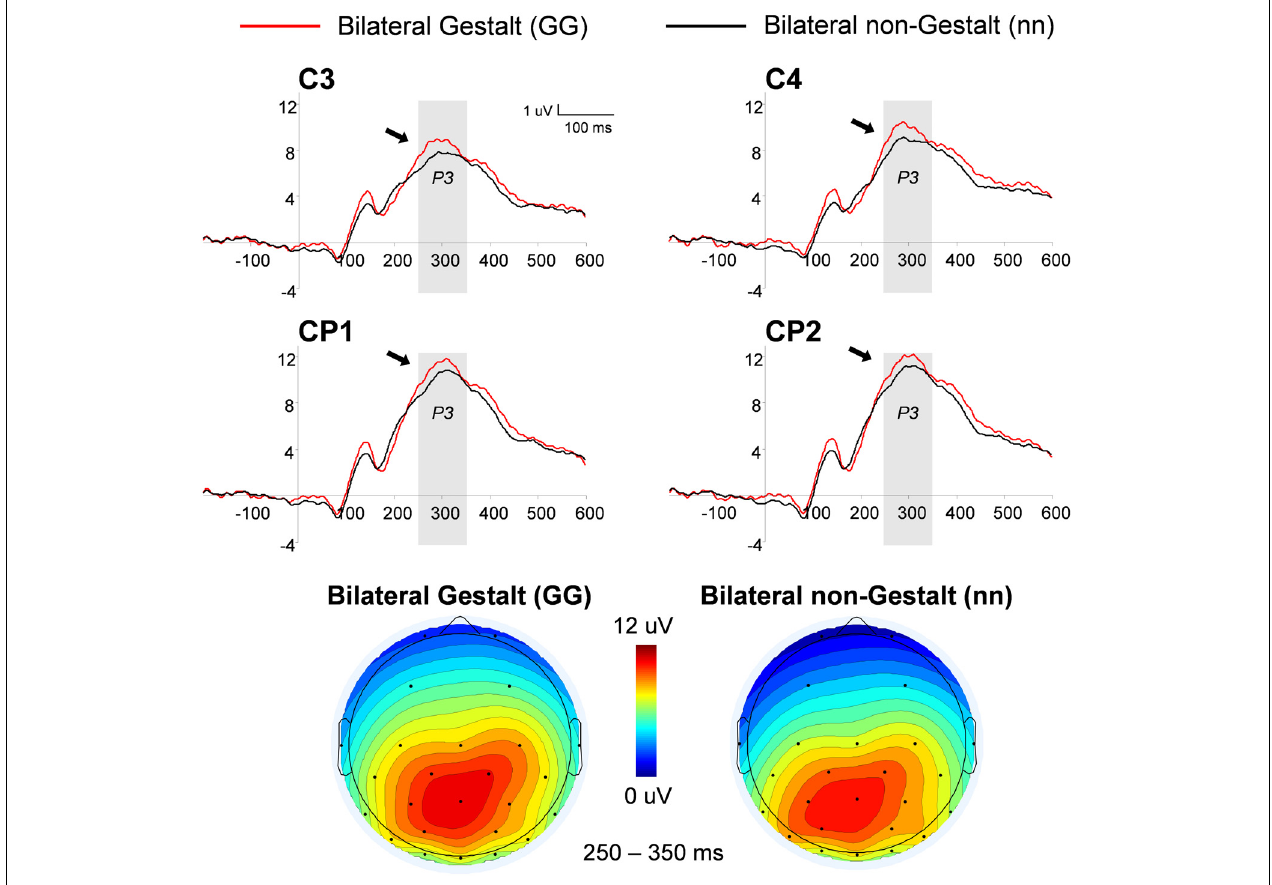
FIGURE 5 | Grand-average and voltage maps of centro-parietal (CP) ERP waveforms for bilateral Gestalt and non-Gestalt stimuli. Average ERP waveforms throughout the epochs ( − 200–600 ms) for bilateral Gestalt (red line) and bilateral non-Gestalt (black line) stimuli at central (C) and CP electrodes on both hemispheres. Arrows indicate significant effects for the P3 component and the shaded gray areas indicate time-windows in which significant effects were found. Maps on the bottom show the average voltage maps relative to the bilateral Gestalt (left) and bilateral non-Gestalt (right) conditions within the 250–350 ms